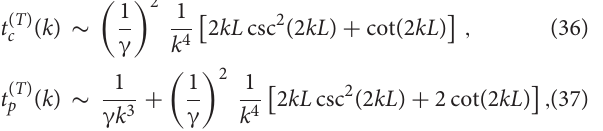
350 and k 2.0 . (B) Double = =